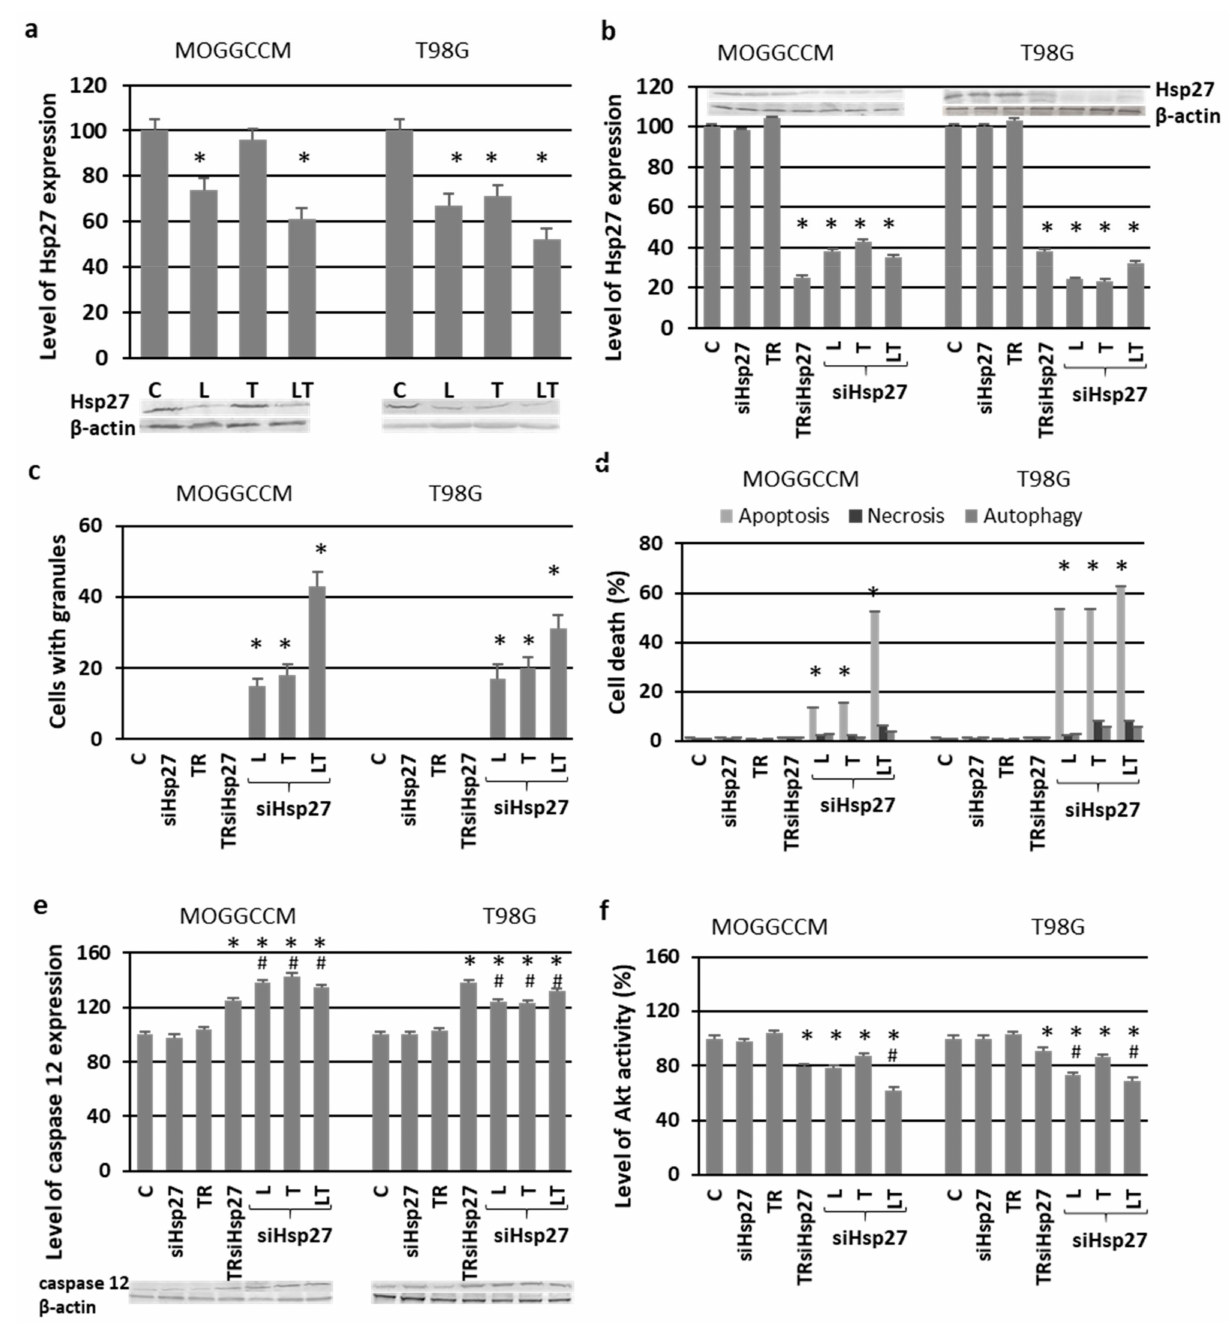
Figure 10. The effect of Hsp27 blocking by specific siRNA (siHsp27) and subsequent temozolomide (T) and LY294002 (L) incubation on the level of Hsp27 expression with representative blots ( a , b ); granule formation estimated microscopically ( c ); apoptosis, autophagy, and necrosis identified microscopically after staining with Hoechst 33342, acridine orange and propidium iodide, respectively; ( d ) the level of caspase 12 with blots ( e ); and Akt activity ( f ). C—control, TR—cells incubated with transfection reagent only, TRsiHsp27—cells incubated with transfection reagent and siHsp27, * p < 0.01 compared to control, # p < 0.01 compared to